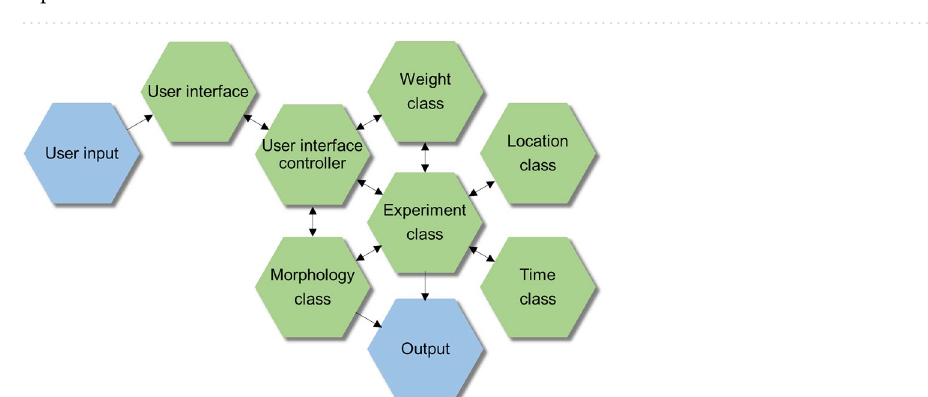
Figure 2. Software architecture of NRN-EZ. Schematic representation of the fundamental structure and design for the NRN-EZ software. The blue hexagons highlight the start and end points of the logical workflow (i.e., the parameter choice from the GUI and the output file generated using NRN-EZ. The green hexagons identify intermediate workflow